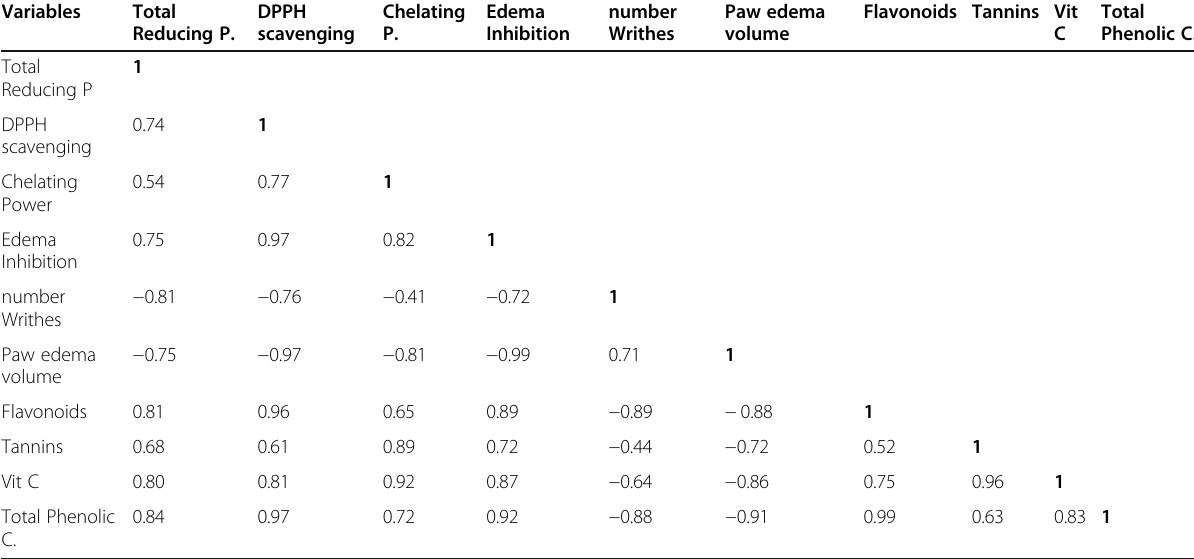
Table 7 Correlation between antioxidant activities, phenolic compound, anti-inflammatory and analgesic activities Variables Total DPPH Reducing P.